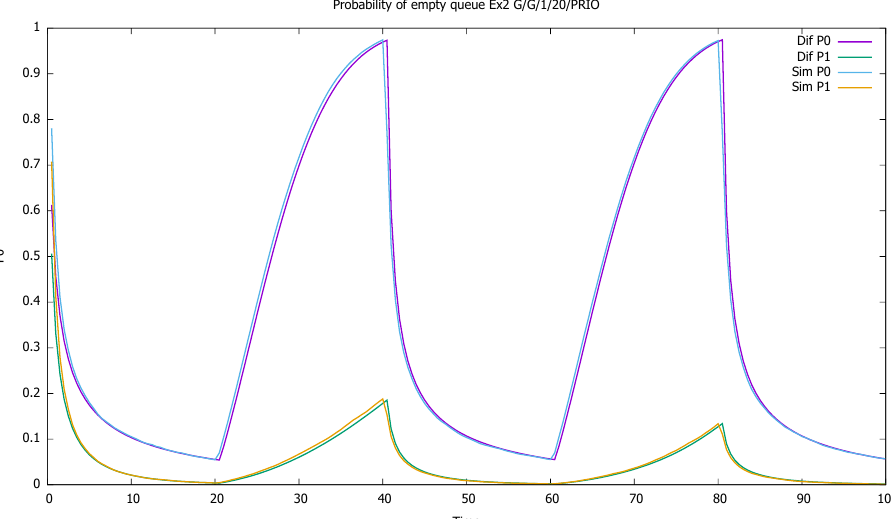
Figure 7. Section 3.2, medium load: probabilities of empty queue p 0 ( t ) for priority (P0) and non- priority (P1)